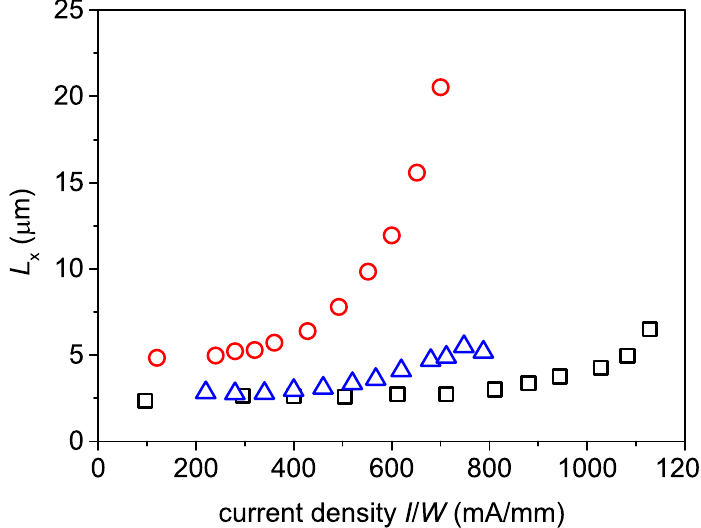
Figure 5. The dependence of L x on the current density for different samples; AlGaN/GaN (squares), AlGaN/AlN/GaN (triangles and